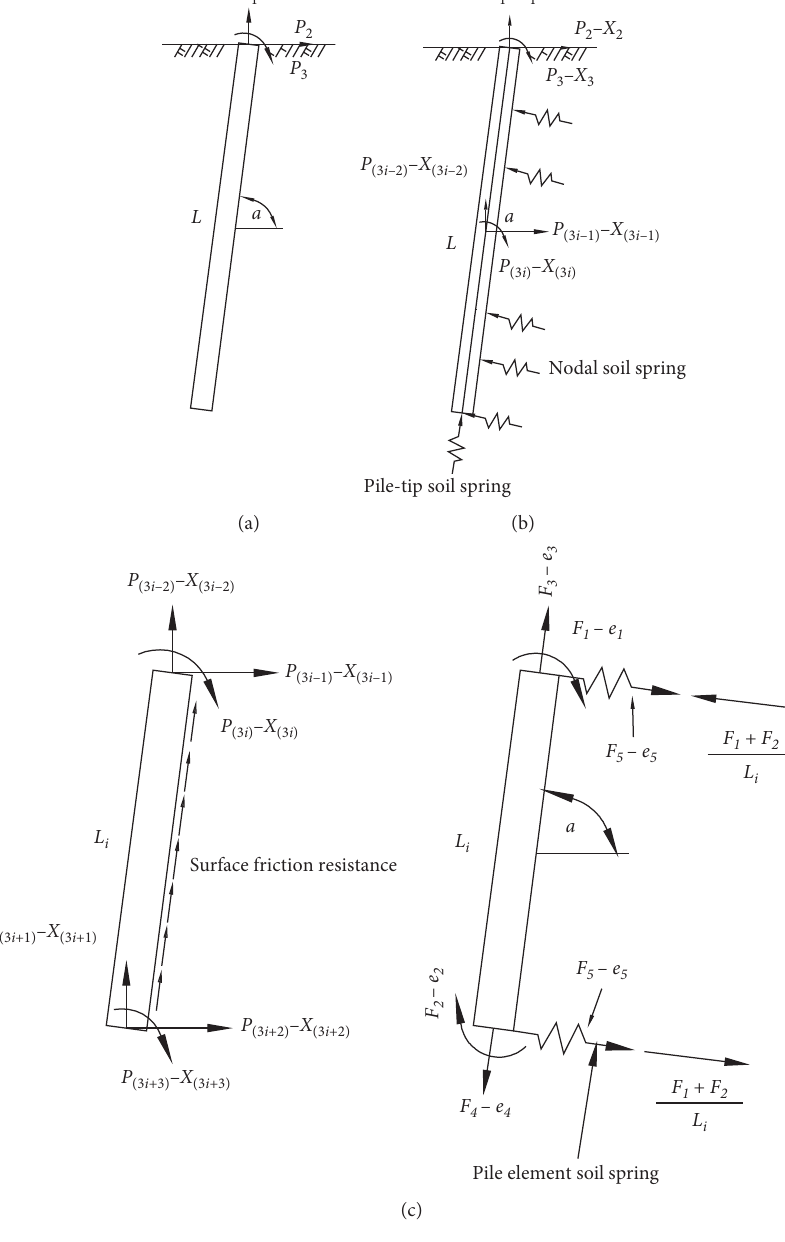
Figure 1: Schematic diagram of coding of pile elements. (a) Pile. (b) Analytical model of the pile. (c) P-X and F-e